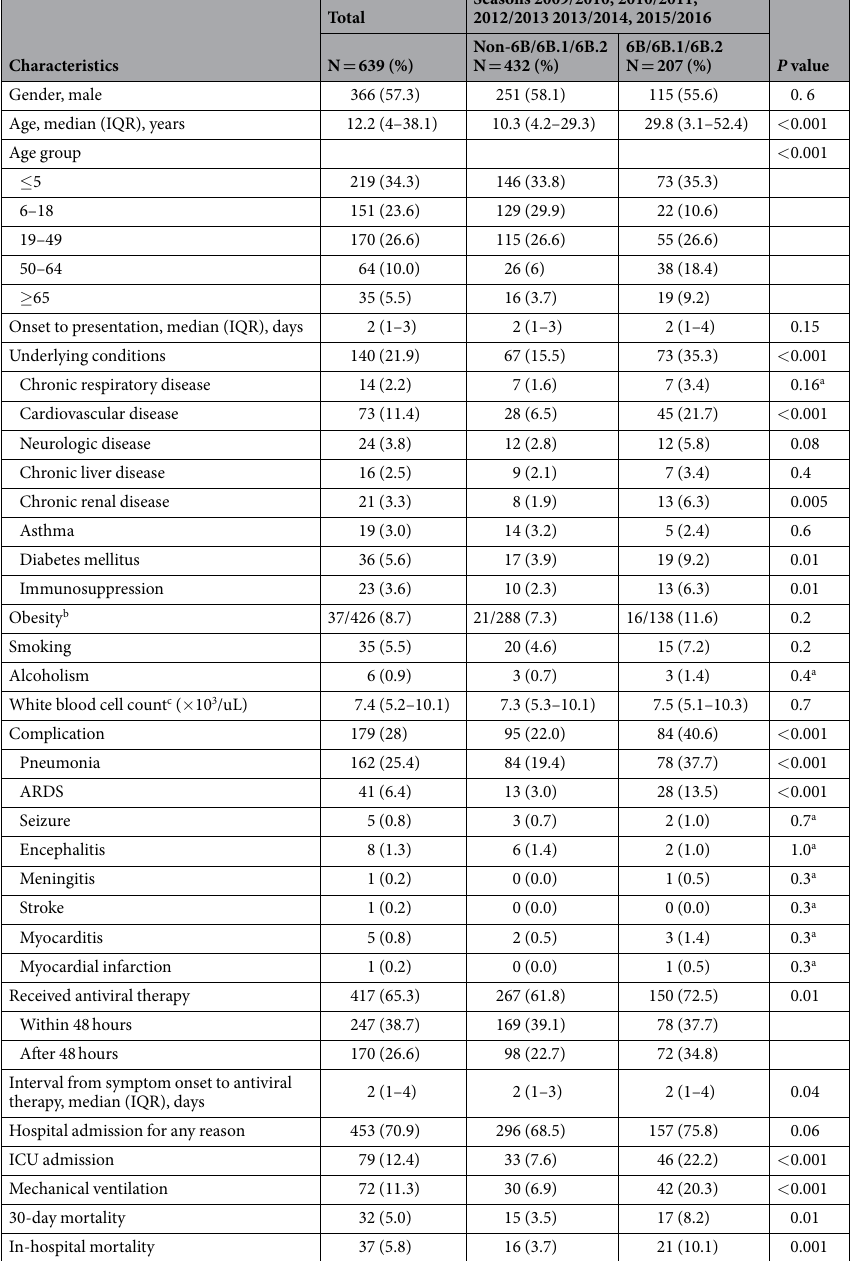
Table 2. Demographic and Clinical Characteristics of Patients with A(H1N1)pdm09 Infection in the clade 6B/6B.1/6B.2-predominant seasons and non-clade 6B/6B.1/6B.2-predominant seasons. a Fisher’s exact